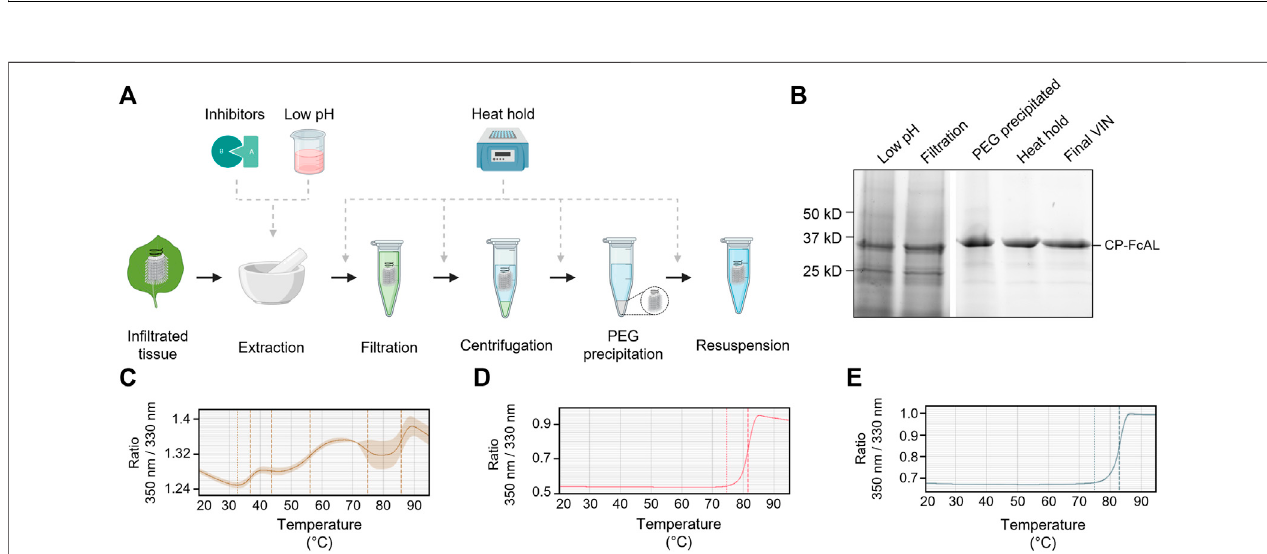
FIGURE4| Asummaryoftheplant virus-basedimmunosorbent nanoparticle(VIN)preparationprocess improvement conducted in thisstudy. (A) An illustration of the VIN preparation stages and the experimental design tested, and (B) SDS-PAGE results of the optimized VIN preparation scheme shown marked at the band height correspondingtoVIN coat protein Fc-af fi nity ligand fusion (CP-FcAL). Nanodifferentialscanning fl uorimetry assessment ofprotein thermostabilityisshown for (C) crude extract at pH 5, (D) VIN prepared according to the optimized scheme, and (E) VIN prepared according to the baseline puri fi cation scheme, using the intrinsic tryptophan and tyrosine residue fl uorescence at 350 nm and 330